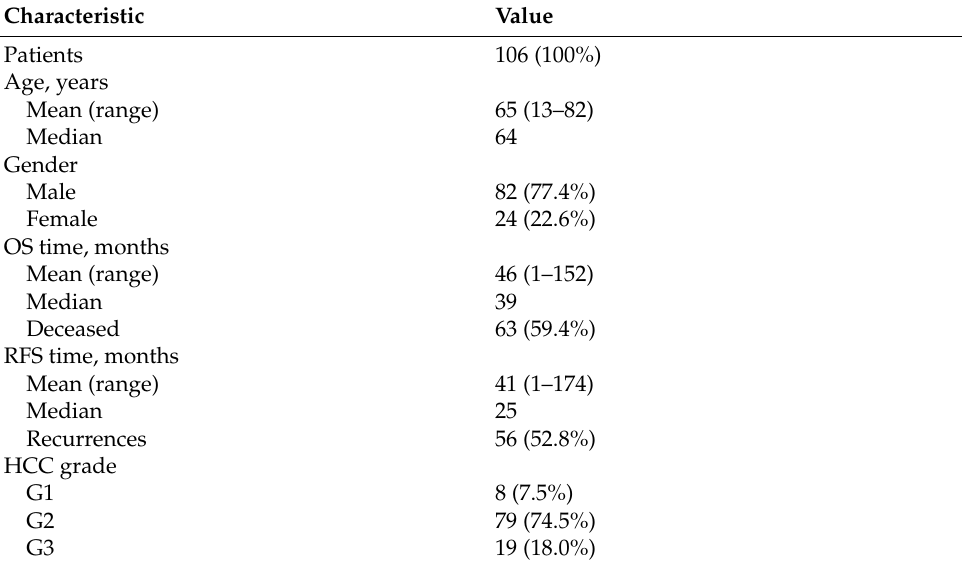
Table 1. Clinical, pathological, and follow-up characteristics of the patient